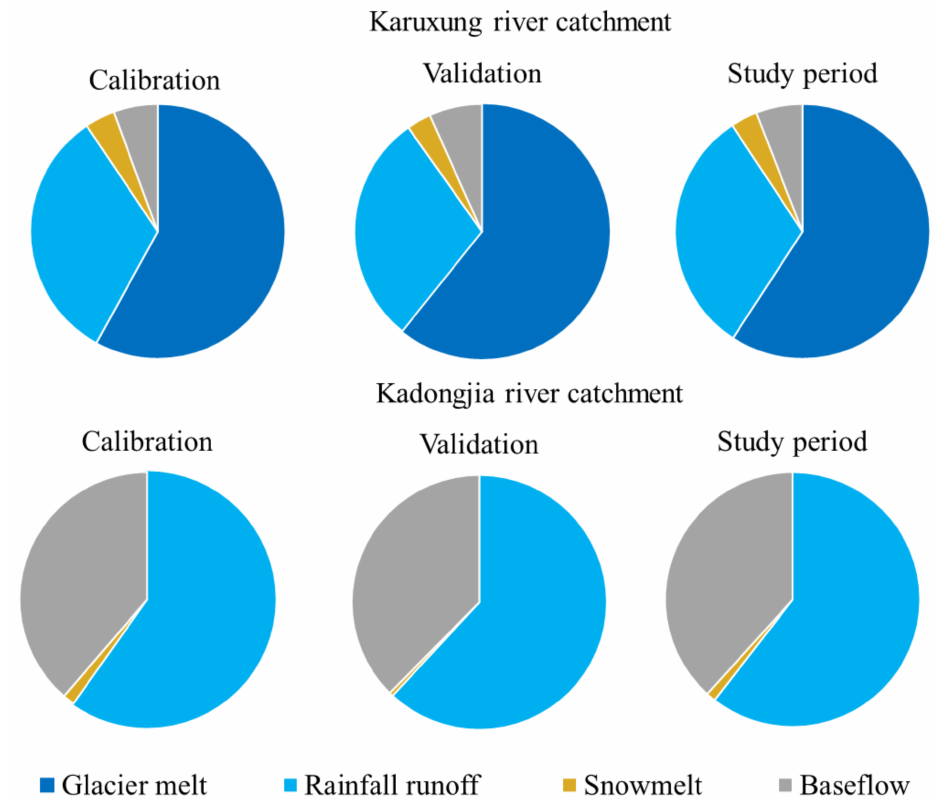
Figure 9. Different components of runoff and their